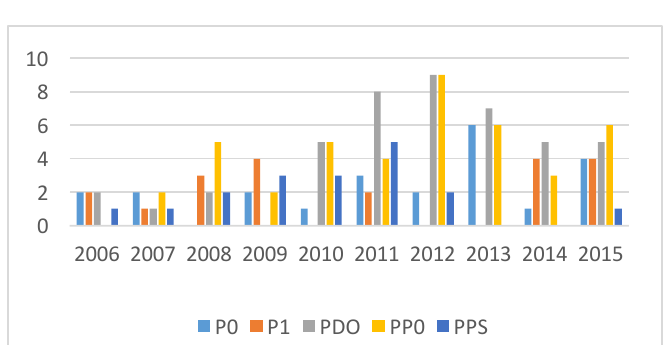
Fig. 6. FEI publications through the lens of the Three Phase Front End Model